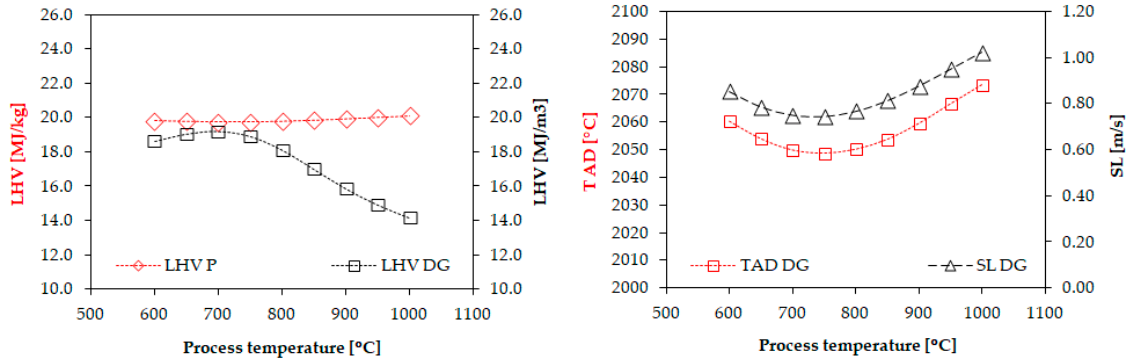
Figure 10. Thermodynamic properties of the raw and dry gas as a function of the pyrolysis processes temperature; residence time of 2 s.